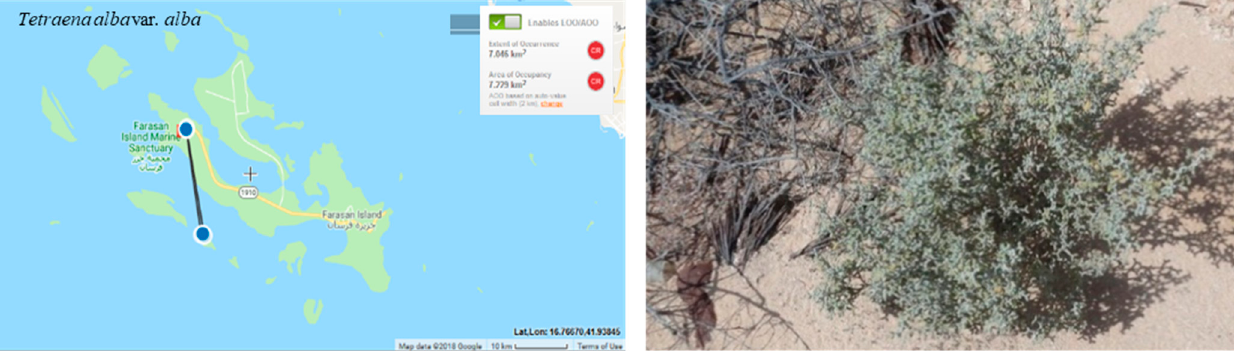
Figure 6. Geographical distribution of Tetraena alba var. alba in the Farasan Archipelago (plant photo by R. Al-Qthanin from Dushak